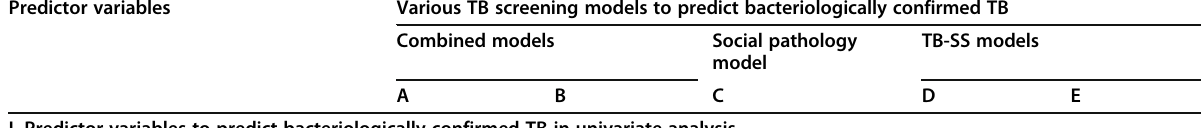
Table 4 Various TB screening models to predict bacteriologically confirmed TB in logistic regression